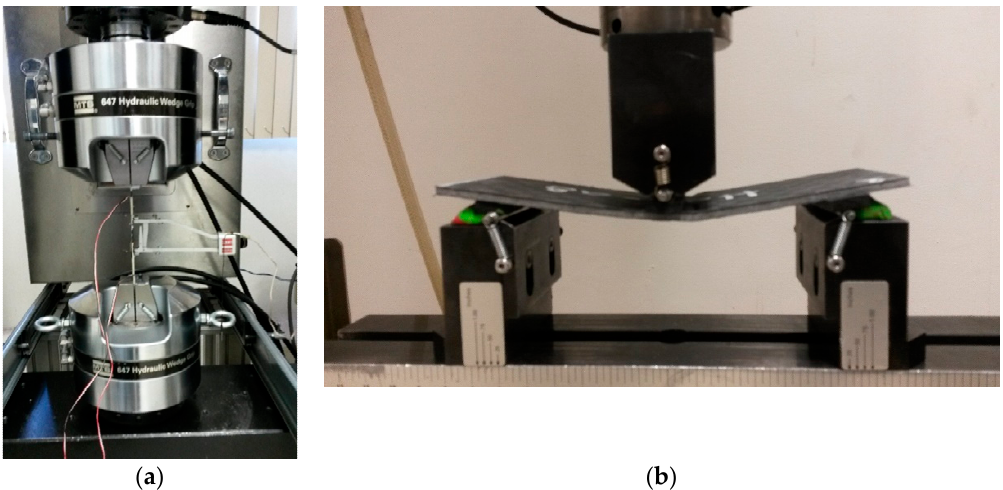
Figure 2. Mechanical characterization for ( a ) CFRP coupons, ( b ) CFRP-PVC foam sandwich